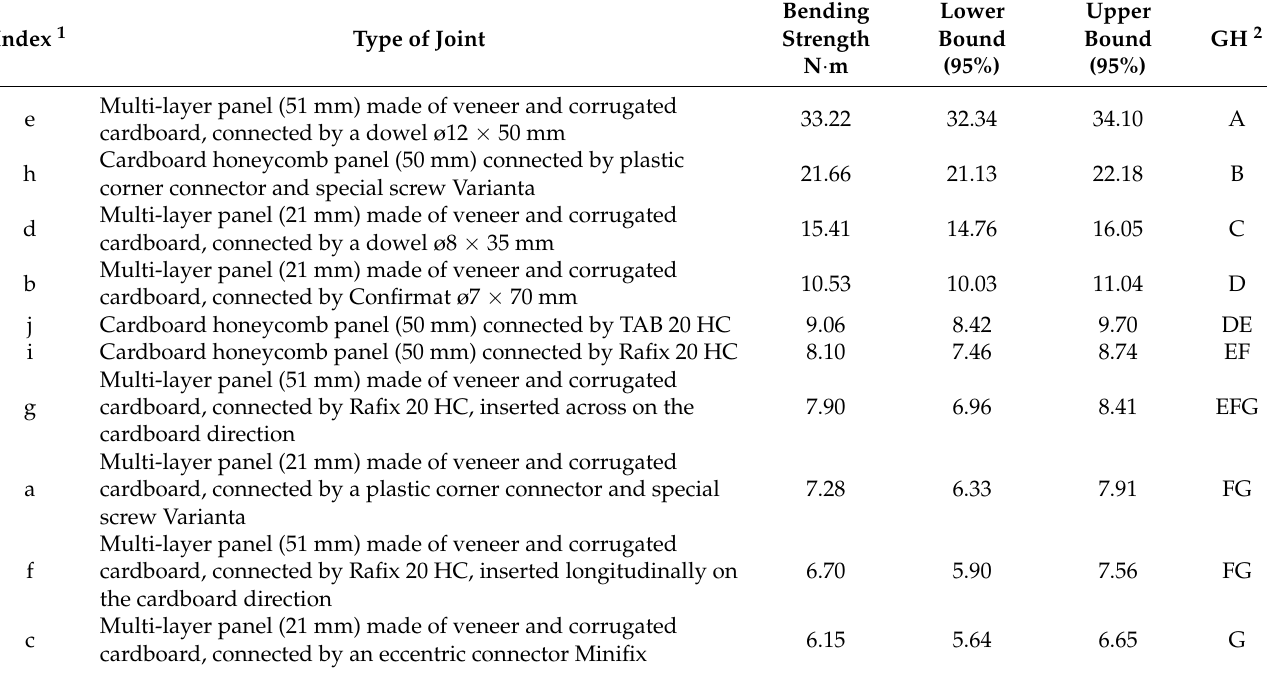
Table 3. Tukey HSD analysis of the differences between the groups with a confidence interval of 95% of bending capacity of joints of two materials of all pairwise comparisons.